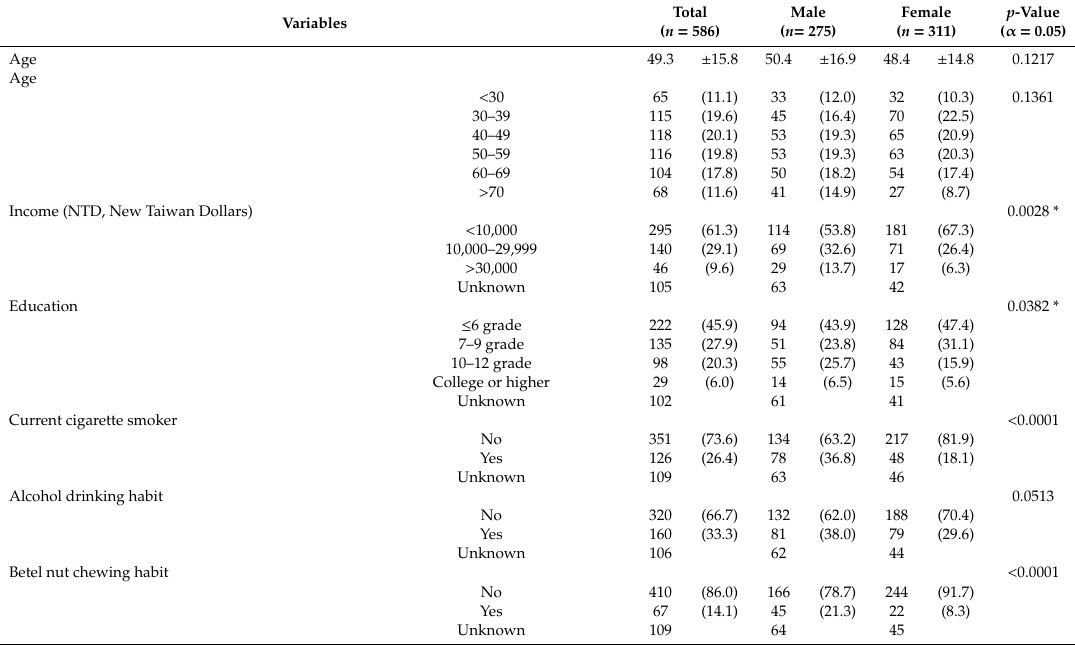
Table 1. Background analysis of basic information, biomarkers and the prevalence of metabolic syndrome of the male and female population ( n =